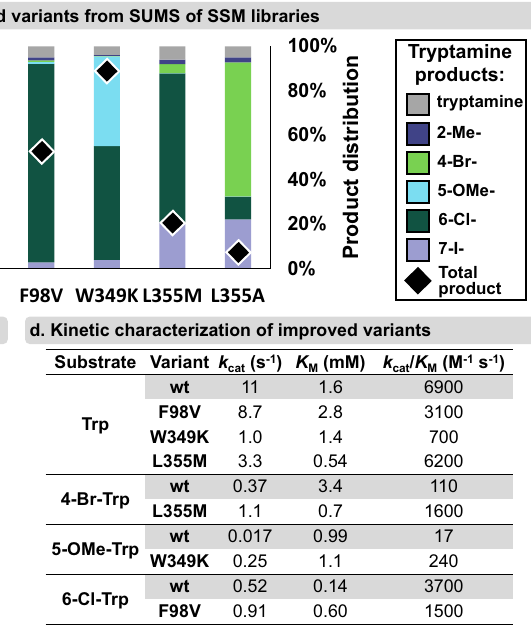
Figs. 6 – S14. c Turnover numbers of wild-type Rgn TDC and the top improved variant for each substrate. Different variants are depicted by different colored bars. Turnover numbers are presented as the averages of technical triplicate measurements with standard deviation shown as a bar. d Michaelis-Menten parameters for wild-type Rgn TDC and activated variants for Trp and Trp ana- logs. Kinetic and turnover data were conducted in triplicate and complete data including error analysis are shown in Supplementary Tables 1 and 2 and Supplementary Figs. 17 –